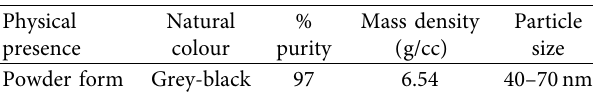
Table 1: Variant physical characteristics of nano-zirconium ) . diboride ( ZrB 2